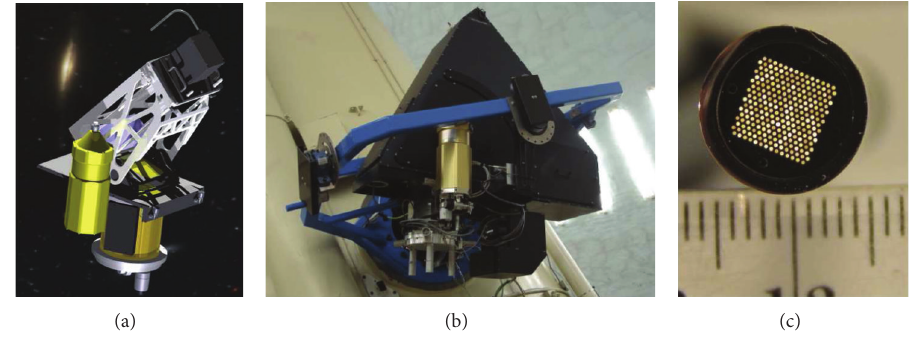
Figure 1: The Mitchell Spectrograph. (a) Diagram showing the interior of the instrument. The casing of the fiber output pseudoslit can be seen in black at the top right, from there light is reflected onto the collimator mirror (purple), back onto a flat mirror at the position of the pseudo-slit, and down through the VPH grating (yellow) and into the Schmidt camera at the bottom of the spectrograph (gold). Dispersed light is reimaged onto a Fairchild Instruments 2048 × 2048 backside illuminated, antireflection coated CCD. The liquid N 2 dewar is also shown in the foreground. (b) The Mitchell Spectrograph installed on the broken Cassegrain focus of the 2.7 m telescope. The gimbal mount can be seen in blue. (c) A zoom into the input head of the 246 fiber